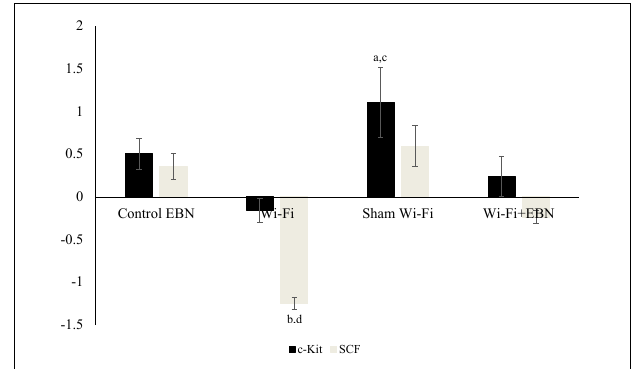
FIGURE 3 | Log 2 fold change of c-Kit and SCF mRNA expression in each group. mRNA expression was determined by qPCR after normalization with β -actin housekeeping gene. Data are expressed as fold change variation relative to the Control group (0 baselines) and presented as mean ± SEM ( n = 6). a Represents a significant difference compared with the Control group. b Represents a significant difference compared with the Control EBN group. c Represents a significant difference compared with the Wi-Fi group. d Represents a significant difference compared with the Sham Wi-Fi group.